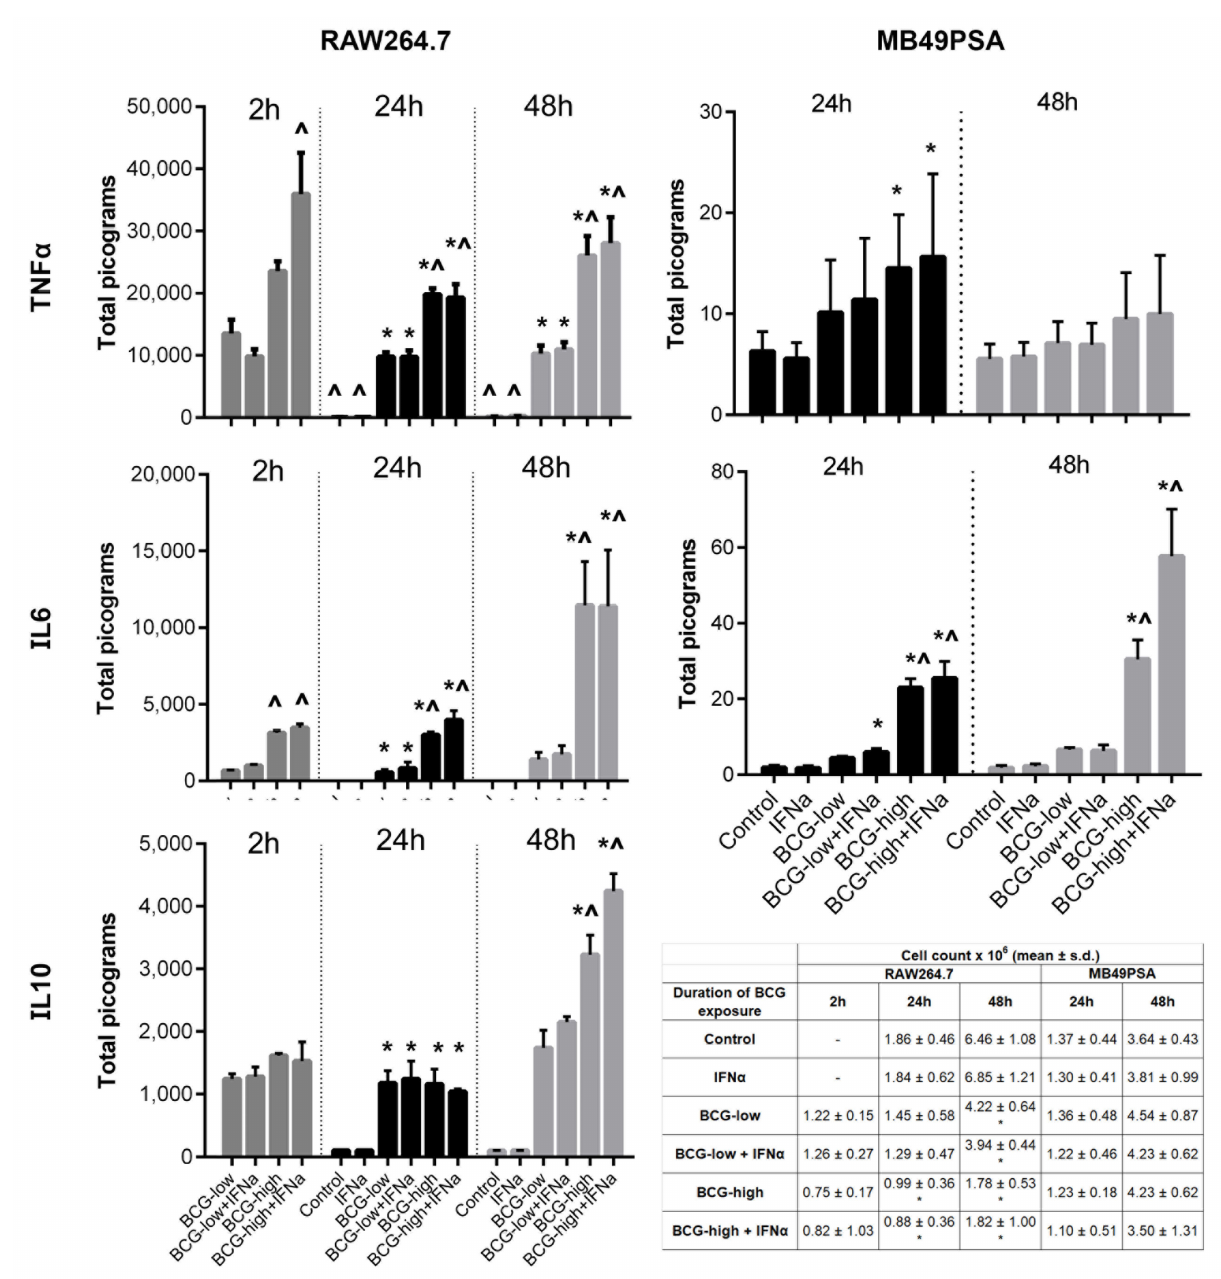
Figure 2. Cytokine production and cell proliferation in RAW264.7 macrophages and MB49PSA cells stimulated with different doses of BCG Tokyo singly or in combination with recombinant IFN α . BCG-low refers to low dose BCG, which is set at MOI of 1:1 for RAW264.7 and 1:4 for MB49PSA. BCG-high refers to high dose BCG (MOI 1:5 for RAW264.7 and 1:40